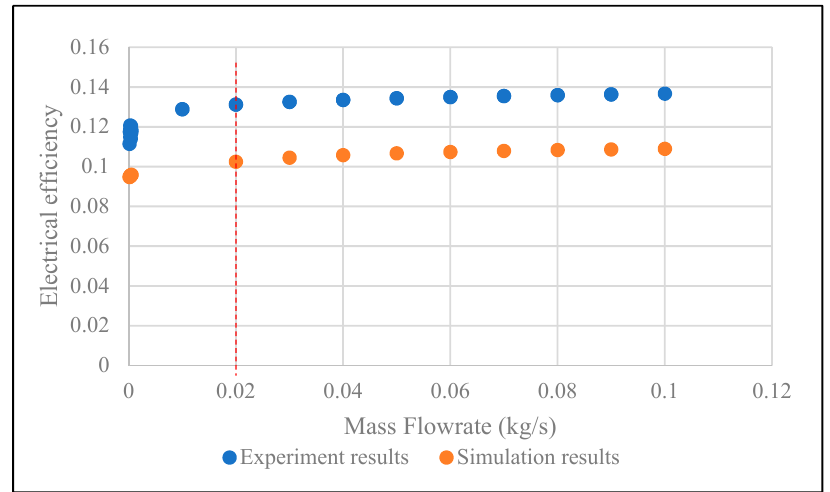
Figure 8. Comparison between the theoretical and experimental results on the effect of air mass flow rate to the electrical e ffi ciency at G = 800–900 Wm − 2 and T a , avg = 310 K.